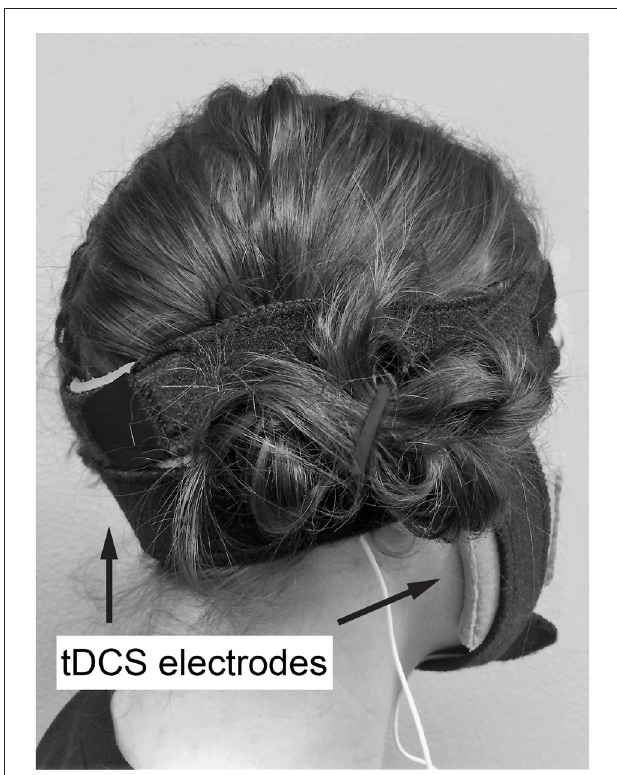
FIGURE 1 | Example of transcranial direct current stimulation (tDCS) electrode placement. Active electrode at a midpoint between the level of the mastoid process and inion, along the posterior midline of the head, reference on buccinator muscle ipsilateral to the trained